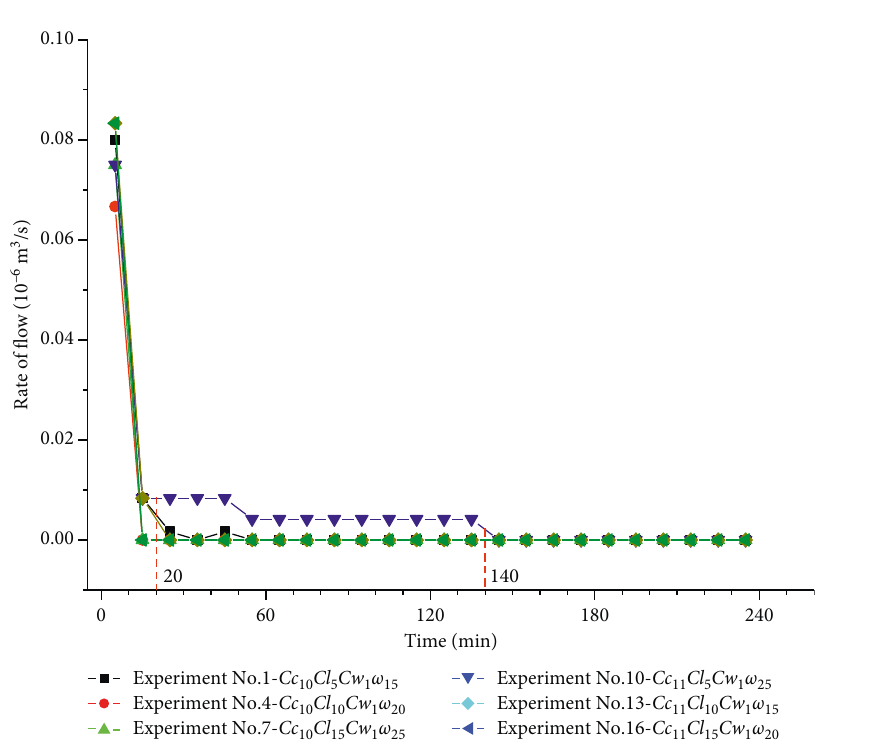
Figure 9: Change curve of the crack rate of flow that decreases to 0m 3 /s.